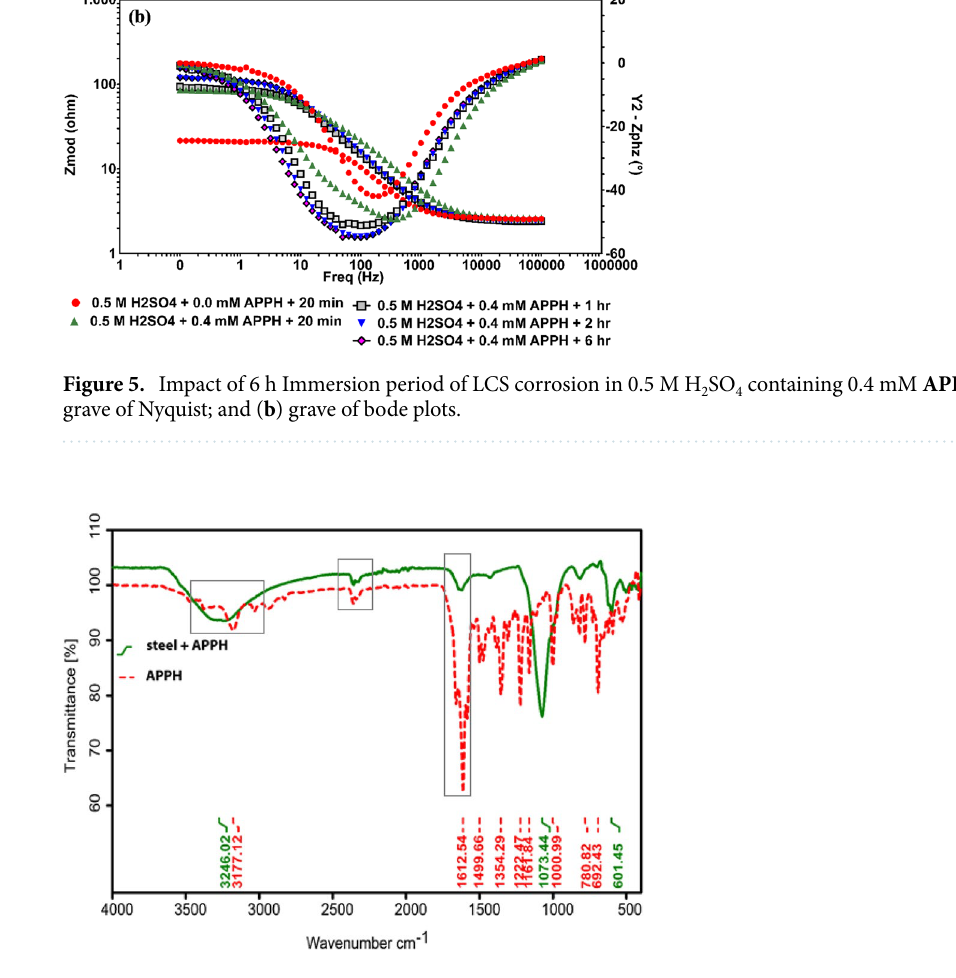
Figure 6. IR spectrum of APPH separately and on the LCS surface in 0.5 M H 2 SO 4